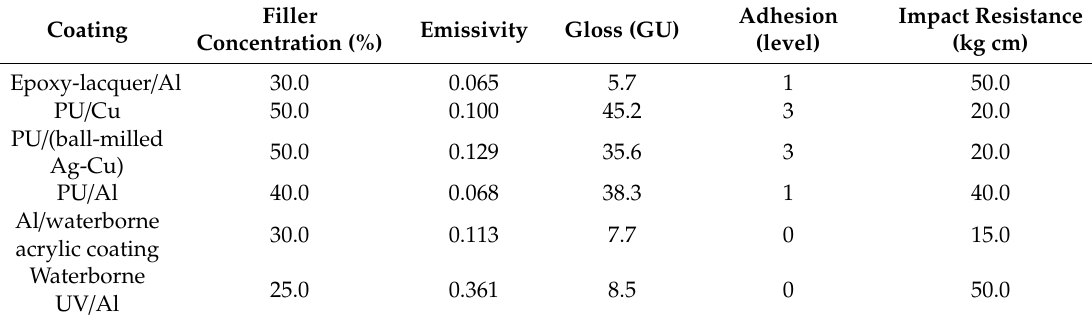
Table 9. Performance comparison of the waterborne UV-based coating with epoxy-lacquer-based coatings, PU-based coatings and waterborne acrylic-based coatings.